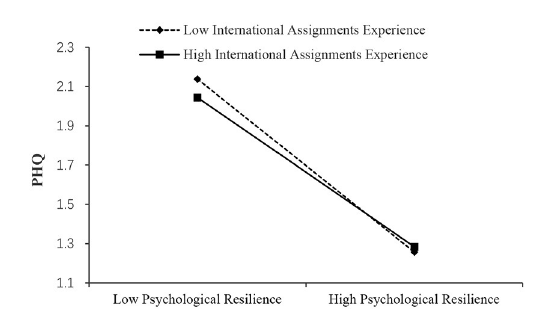
FIGURE4 Simple slopes of international assignments experience moderate the effect of psychological resilience on PHQ.